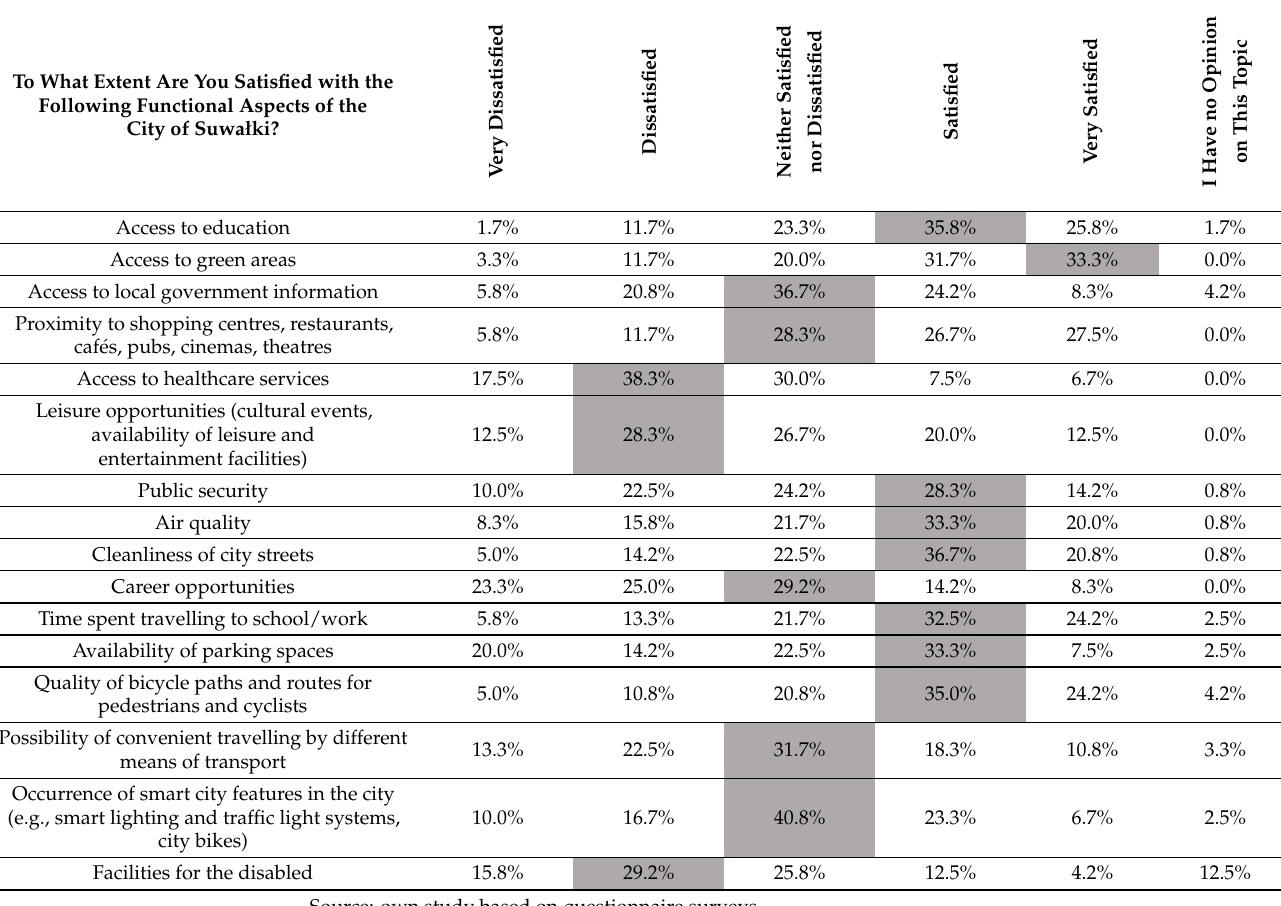
Table 4. The level of inhabitants’ satisfaction with individual functional aspects of the city of Suwałki.